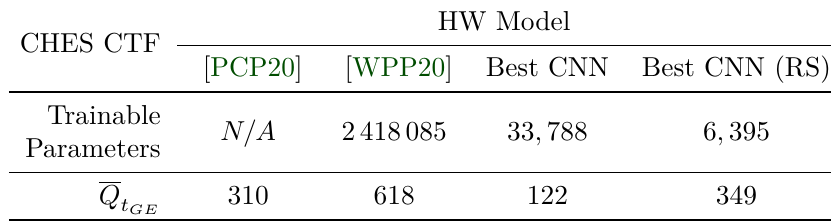
Table 6: Comparison of the top generated CNNs for the CHES CTF and HW leakage model experiments with the current